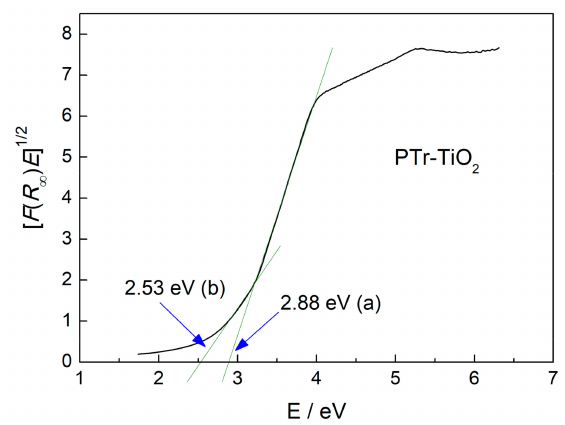
Figure 7. Plot of transformed Kubelka–Munk function vs. energy of light for the PTr–TiO 2 sample. Determination of band gap energy ( a ) and absorption onset ( b